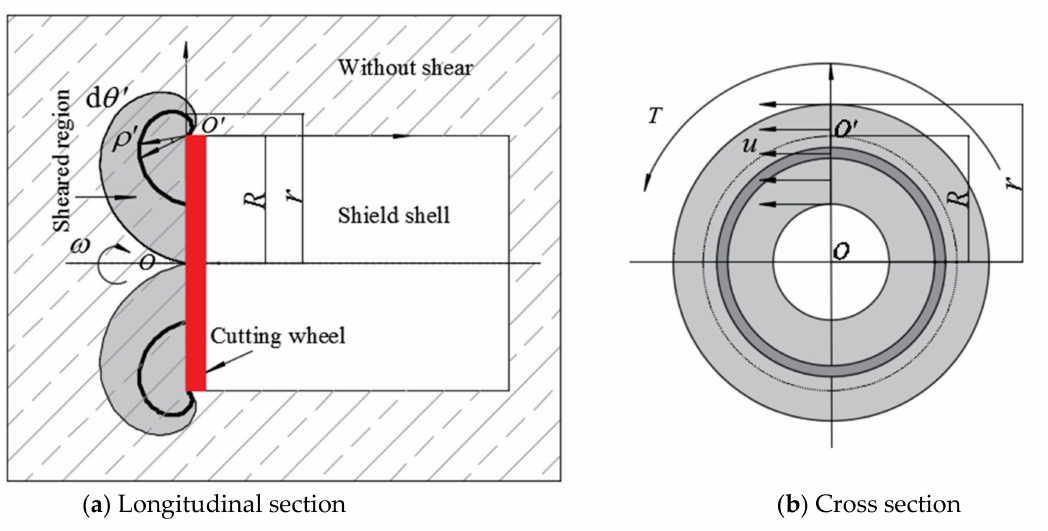
Figure 3. Cutting wheel–soil shear flow